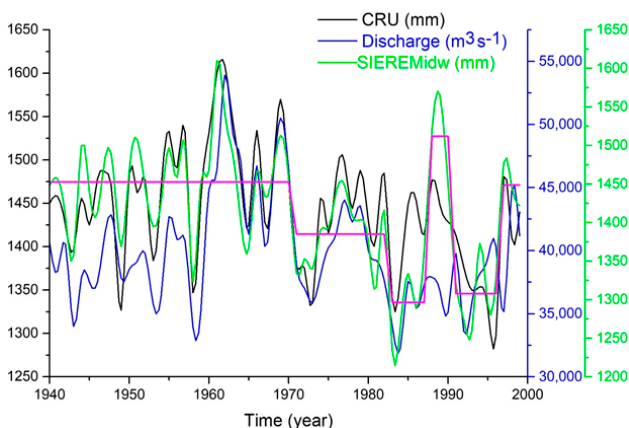
Figure 7. Regionalized annual rainfall over the whole Congo River Basin with phases of homogeneous rainfall (horizontal red lines). CRU (black) and SIEREM (green) gridded data set are compared, together with discharges time series (blue).